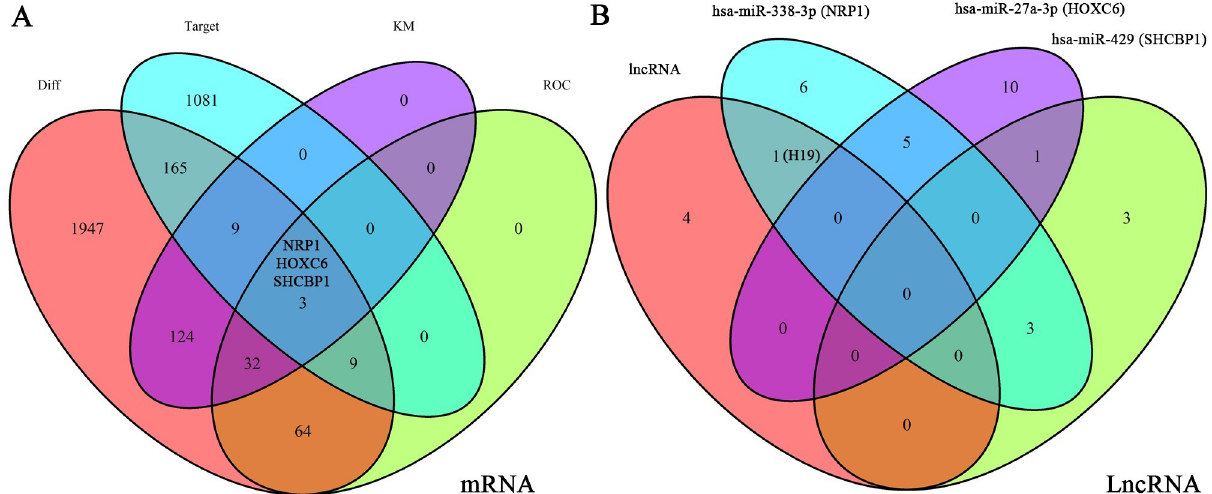
Fig 5. Screening for differentially expressed lncRNAs and miRNAs. (a) The intersection of the differentially expressed mRNAs, miRNAs predicted to bind these mRNAs, Kaplan–Meyer analysis, and ROC analysis was to find meaningful mRNAs, of which there were three: NRP1, HOXC6, SHCBP1. (b) We analyzed the intersection of the five survival-related lncRNAs with the corresponding lncRNAs of NRP1, HOXC6, and SHCBP1, which revealed the H19-hsa-miR-338-3p-NRP1 signaling axis. At the same time, we show miRNAs that correspond with the three mRNAs.